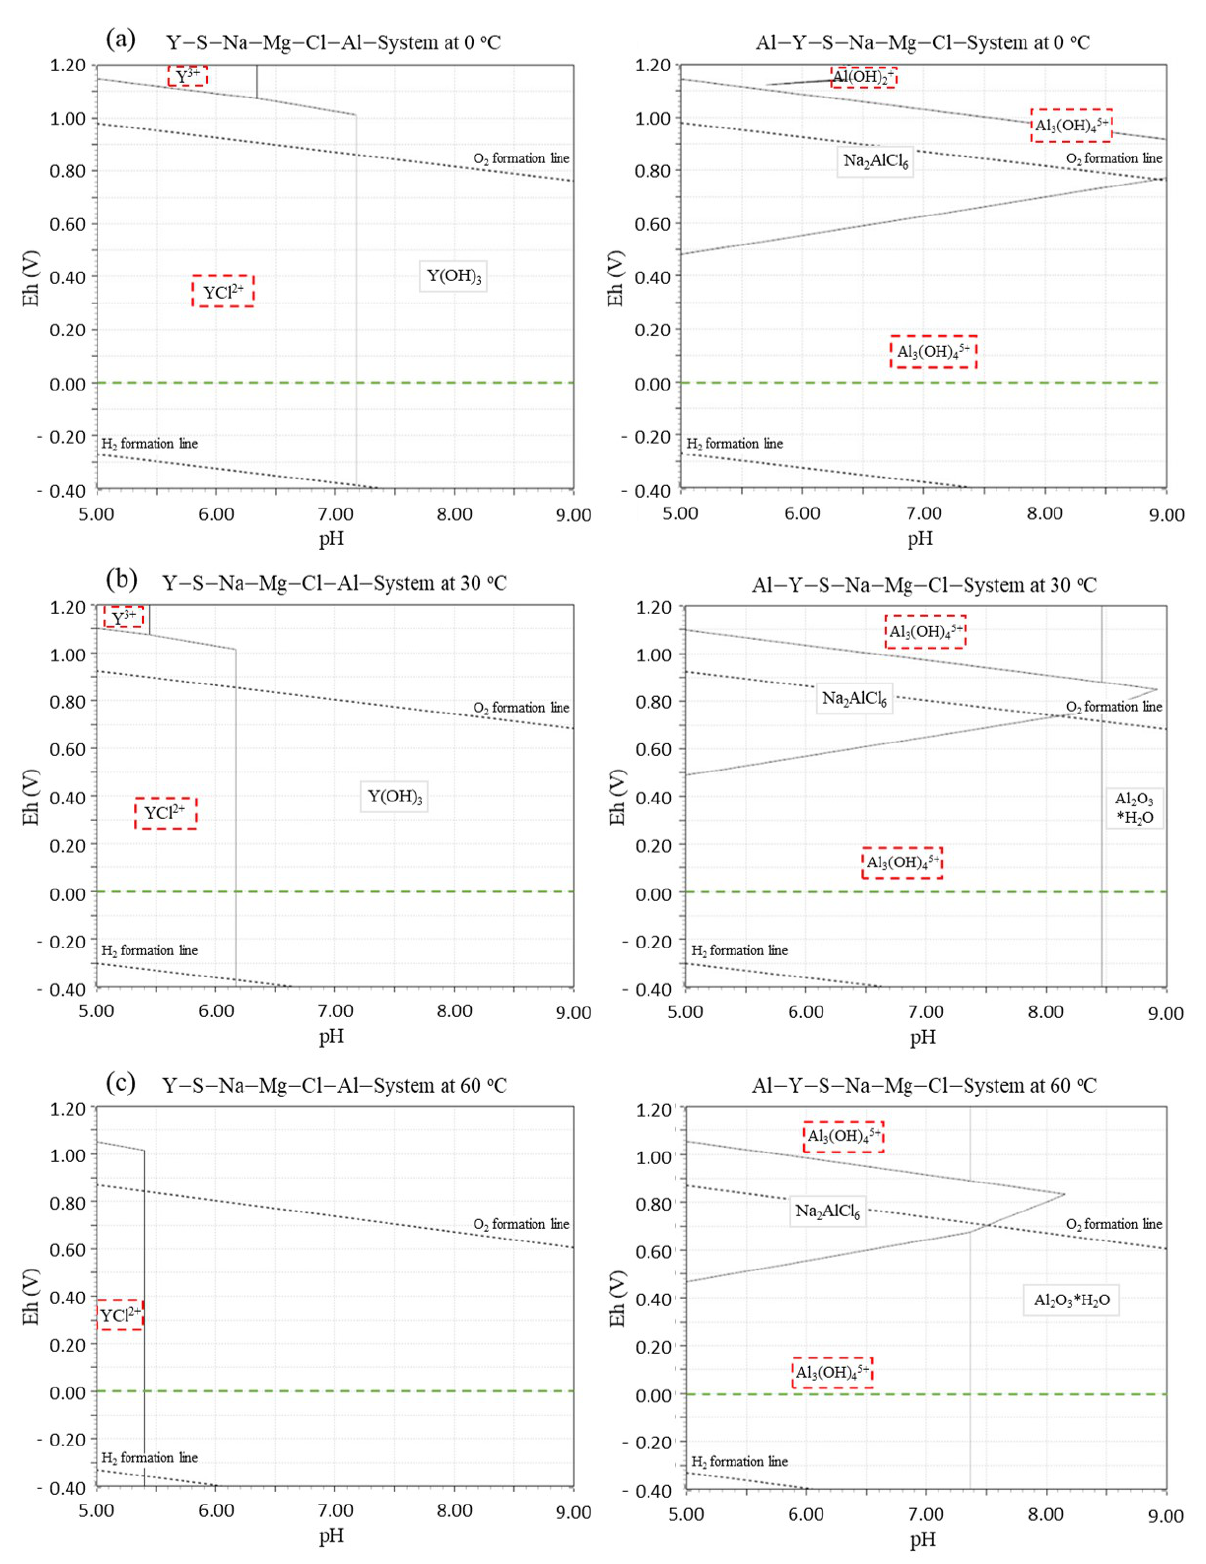
Figure 2. Eh-pH diagrams of YAlO 3 for Y ( left ) and Al ( right ) at ( a ) 0 ◦ C, ( b ) 30 ◦ C, and ( c ) 60 ◦ C in saline